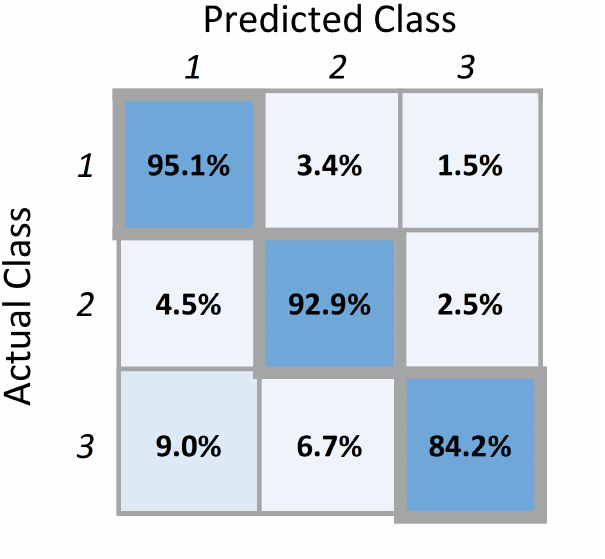
Figure 19. Confusion matrix from the evaluation with Multiclass Decission Forest, with 8 deci- sion trees.